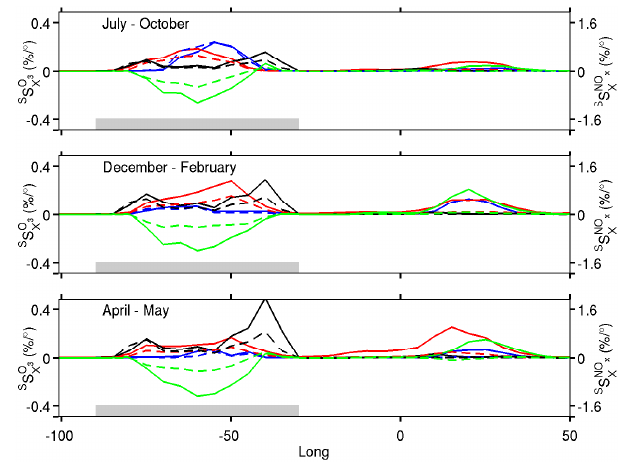
Fig. 6. Adjoint sensitivity of tropical ozone (solid lines) and NO x (dash lines) to changes in the emissions of isoprene (green), light- ning NO x (red, × 0 . 5), biomass burning NO x (blue), soil NO x (cyan) and anthropogenic NO x (black). The grey shaded region denotes the region over which the cost functions are evaluated.